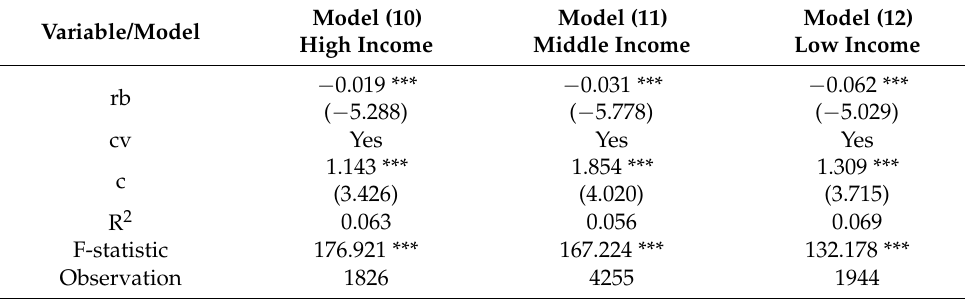
Table 7. Results of heterogeneous effect (income